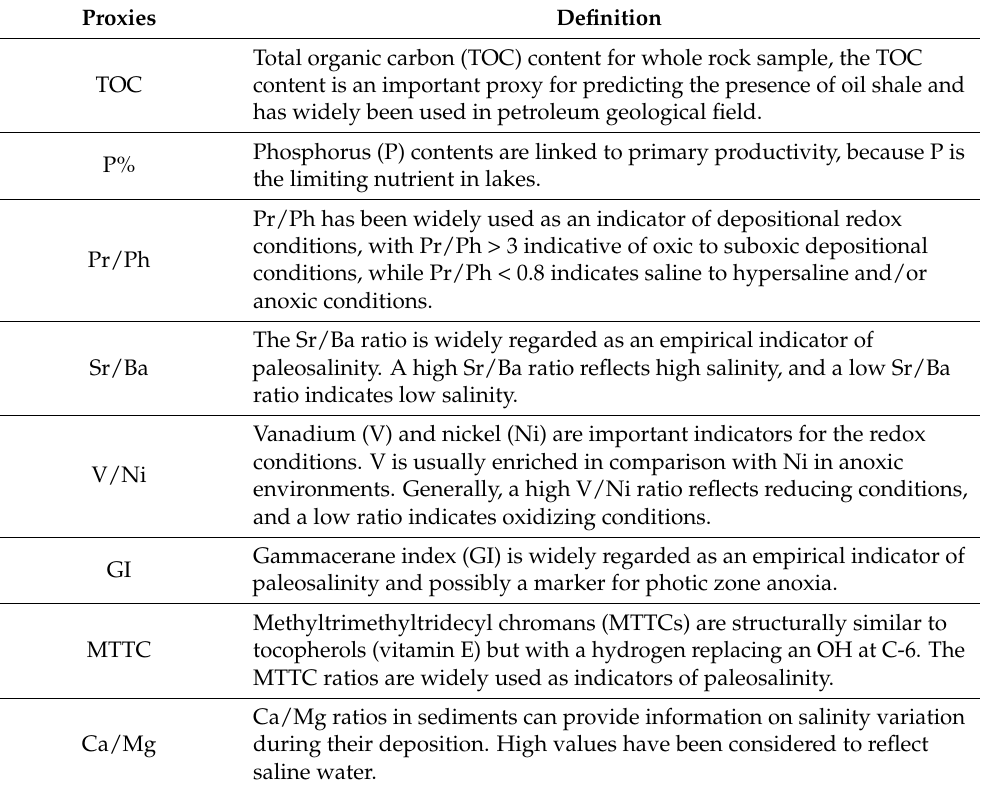
Table 1. Definition of paleoenvironmental proxies used in this